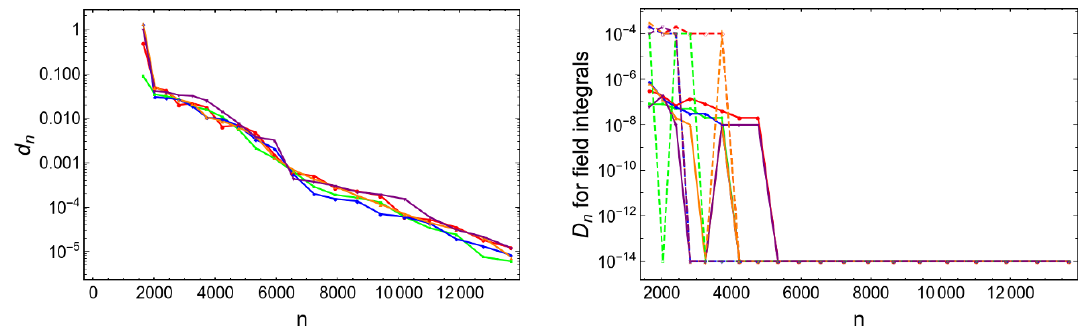
Figure 11 . Left: example convergence plot for a generic random sample: maximum deviation from high resolution solution d n as a function of the total number of grid points n . Right: example convergence plot for a generic random sample: maximum deviation from high resolution solution d n for integrals along the BH horizon (blue: gauge (cid:12)eld integral, orange: scalar (cid:12)eld integral) as a function of the total number of grid points n